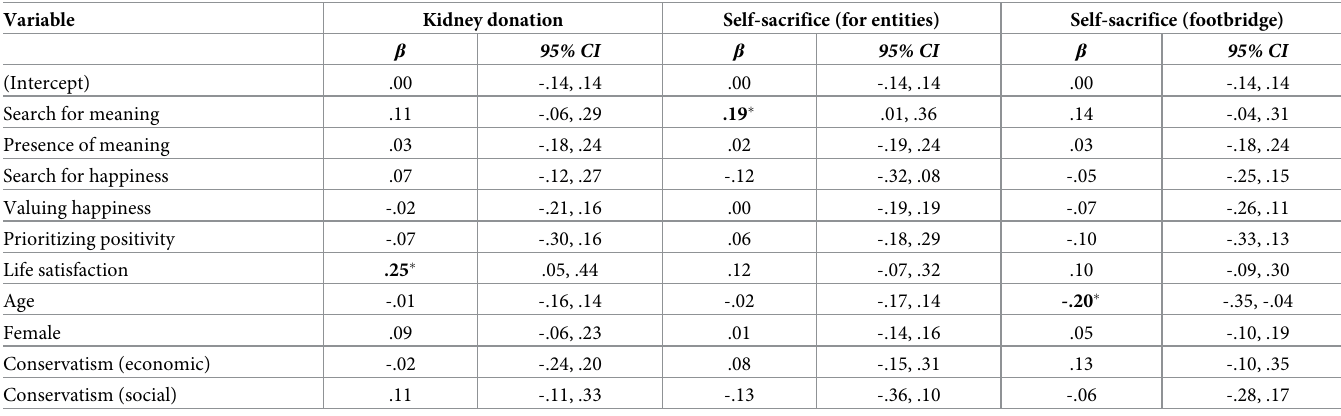
Table 4. Multiple regressions predicting costly prosociality with search for meaning in Study